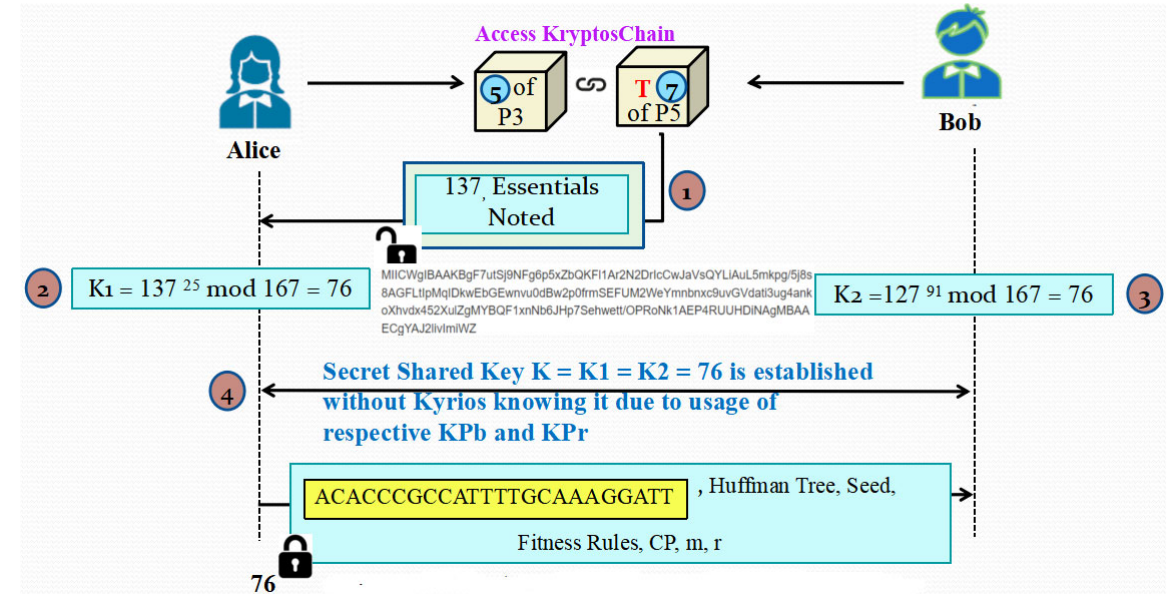
Figure 16. Demonstration of Phase 6: Actual Information Exchange Process.